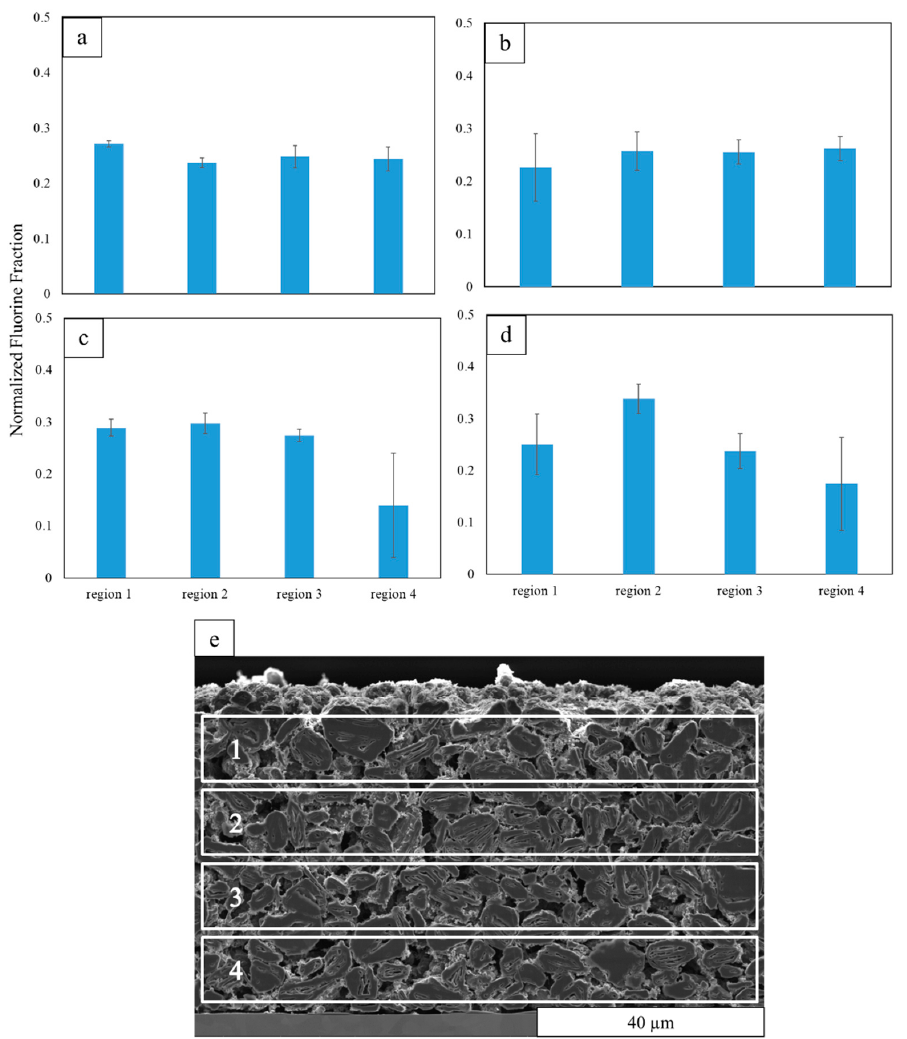
Figure 5. Normalized fluorine fraction at four regions (1 is at the top, and 4 at the bottom) of anodes at different drying temperatures of ( a ) 24 °C, ( b ) 80 °C, ( c ) 150 °C, and ( d ) 232 °C, and ( e ) electrode cross-section regions for EDS quantification. cross-section regions for EDS